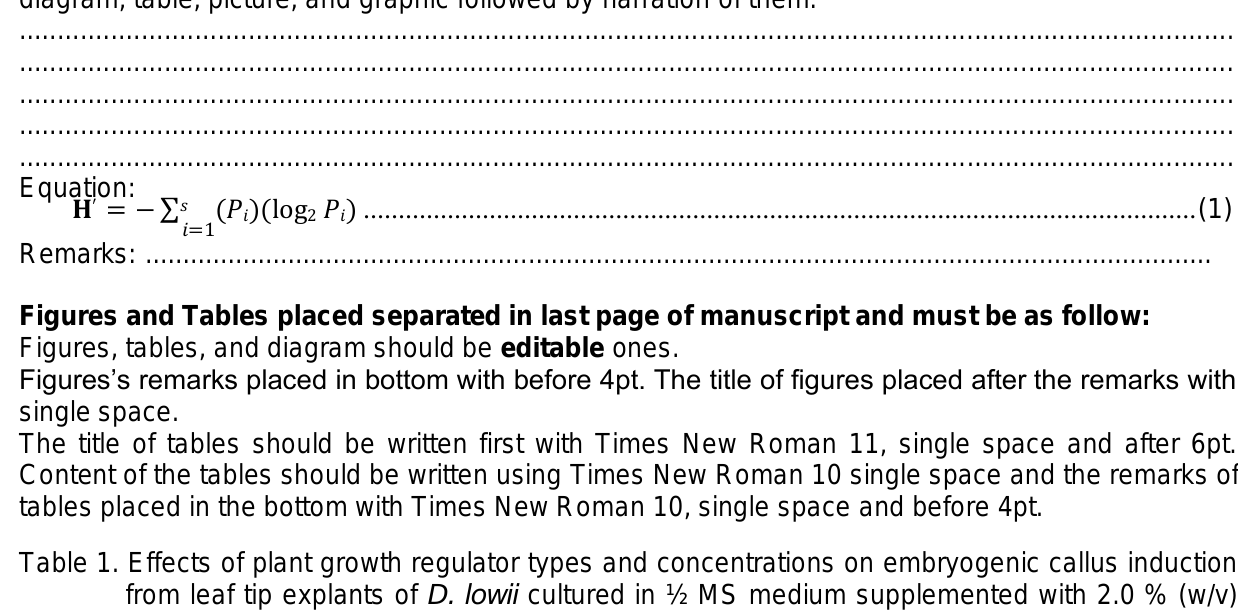
Table 1. Effects of plant growth regulator types and concentrations on embryogenic callus induction